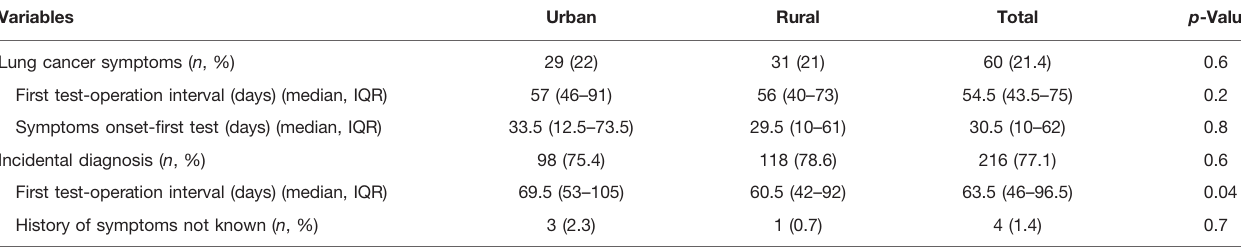
TABLE 2 | Details of analysis according to the presence/absence of cancer-related symptoms. Variables